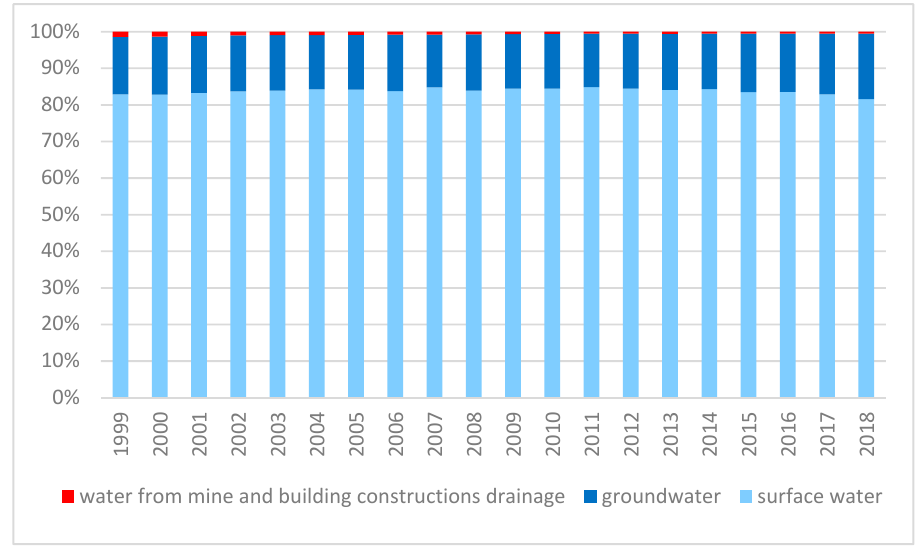
Figure 7. Water intake for the economy and population by source in the period 1999–2018 (based on [26]).